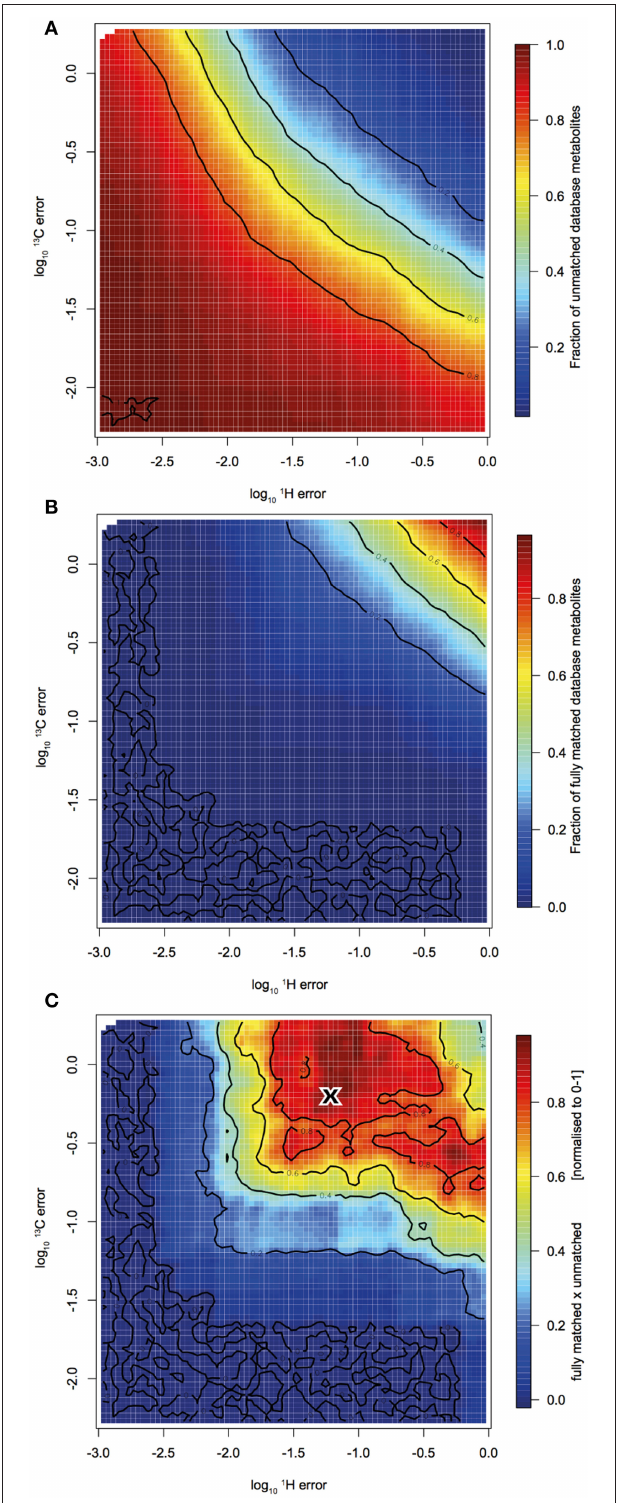
FIGURE 3 | Monte Carlo simulation to find ideal matching error window: HSQC peak - reference spectrum peak matching quality indicators in